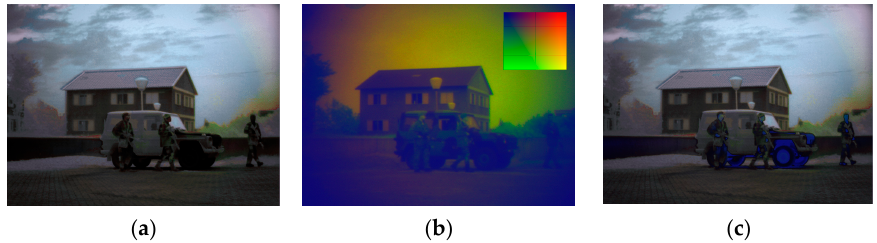
Figure 7. Results from ( a ) the CTN scheme (trained on the standard reference image set from Figure 6a); ( b ) a two-band color transformation in which the colors depend on the visible and NIR sensor values (using the color table depicted in the inset); and ( c ) the salient-hot-target (SHT) method in which hot elements are assigned their corresponding color from ( b ).